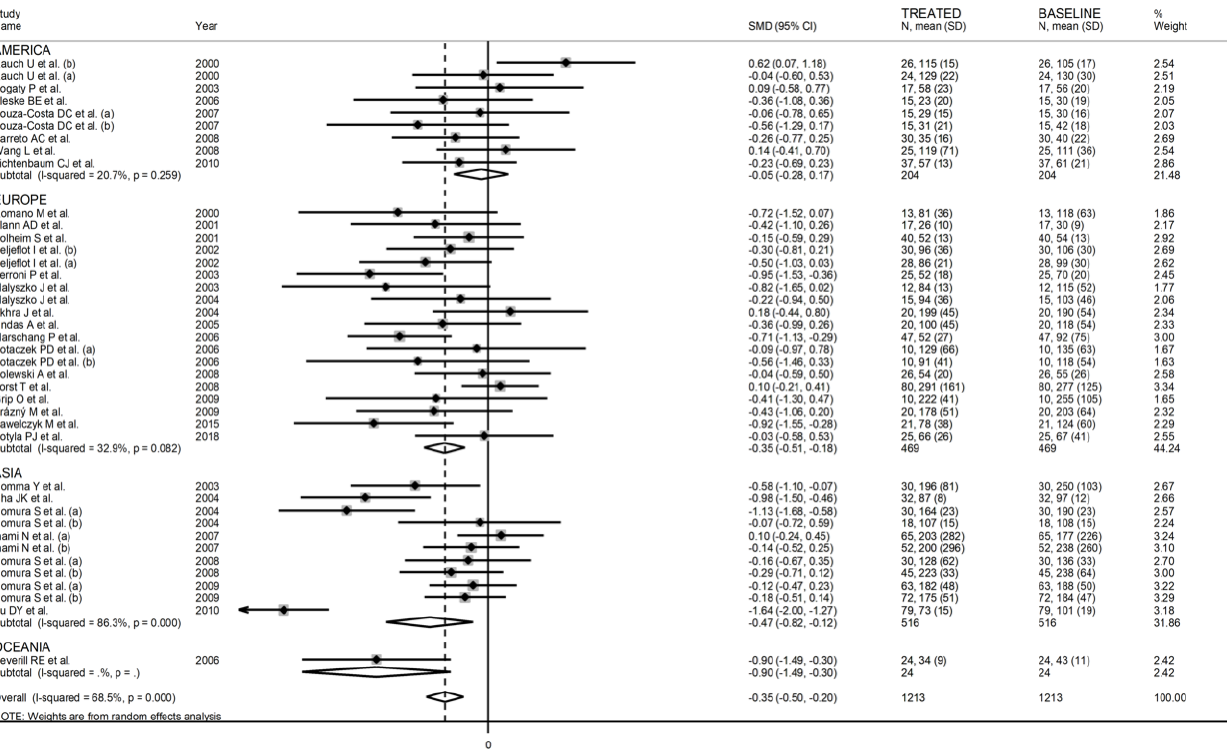
Figure 7. Forest plot of P-Selectin concentrations before and after statin treatment according to continent where the study was conducted.